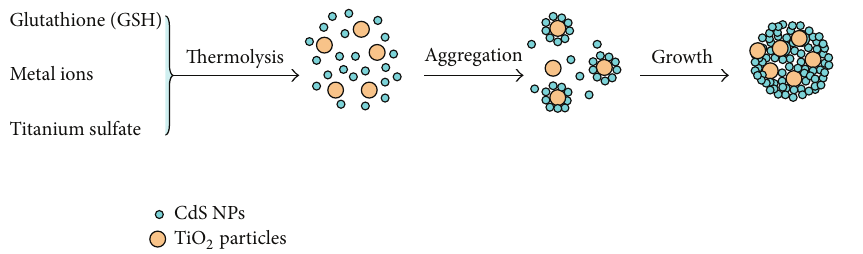
Scheme 1: Illustration of the preparation process of the TiO 2 /CdS mesoporous